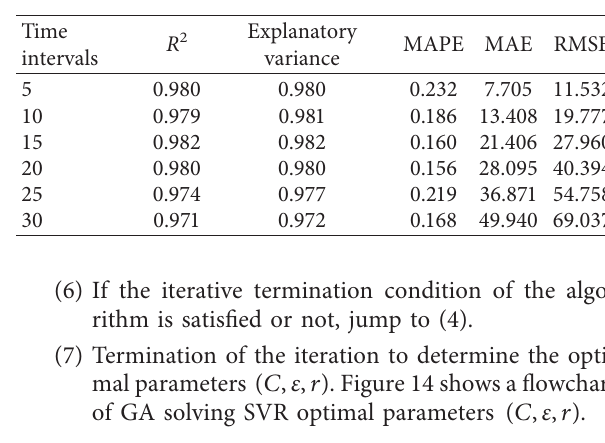
Table 4: Comparison of short-term traffic flow prediction effect at different time